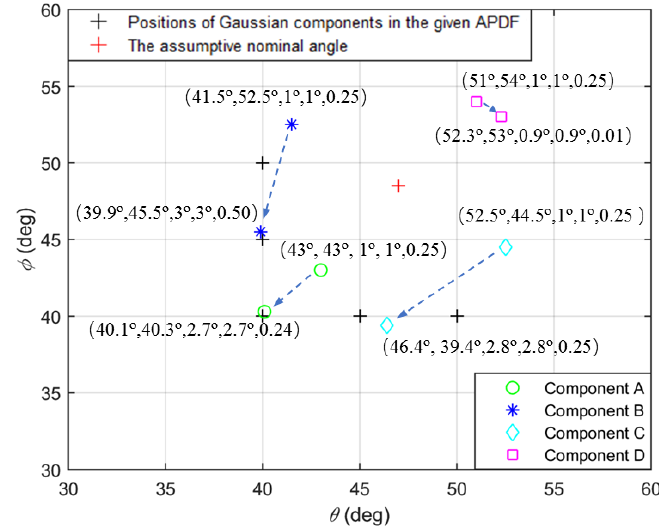
Figure 4. The initial and final values of each Gaussian component.